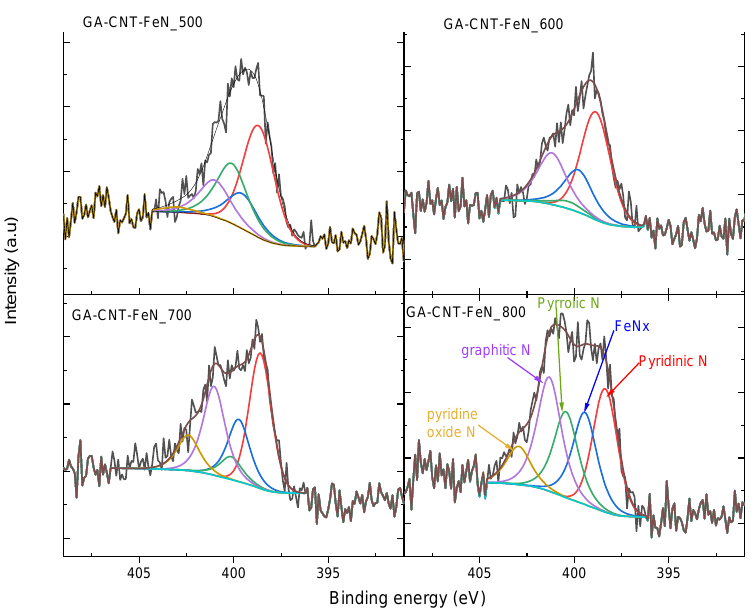
Figure 8. Deconvolution of the N1s XPS core level spectra.